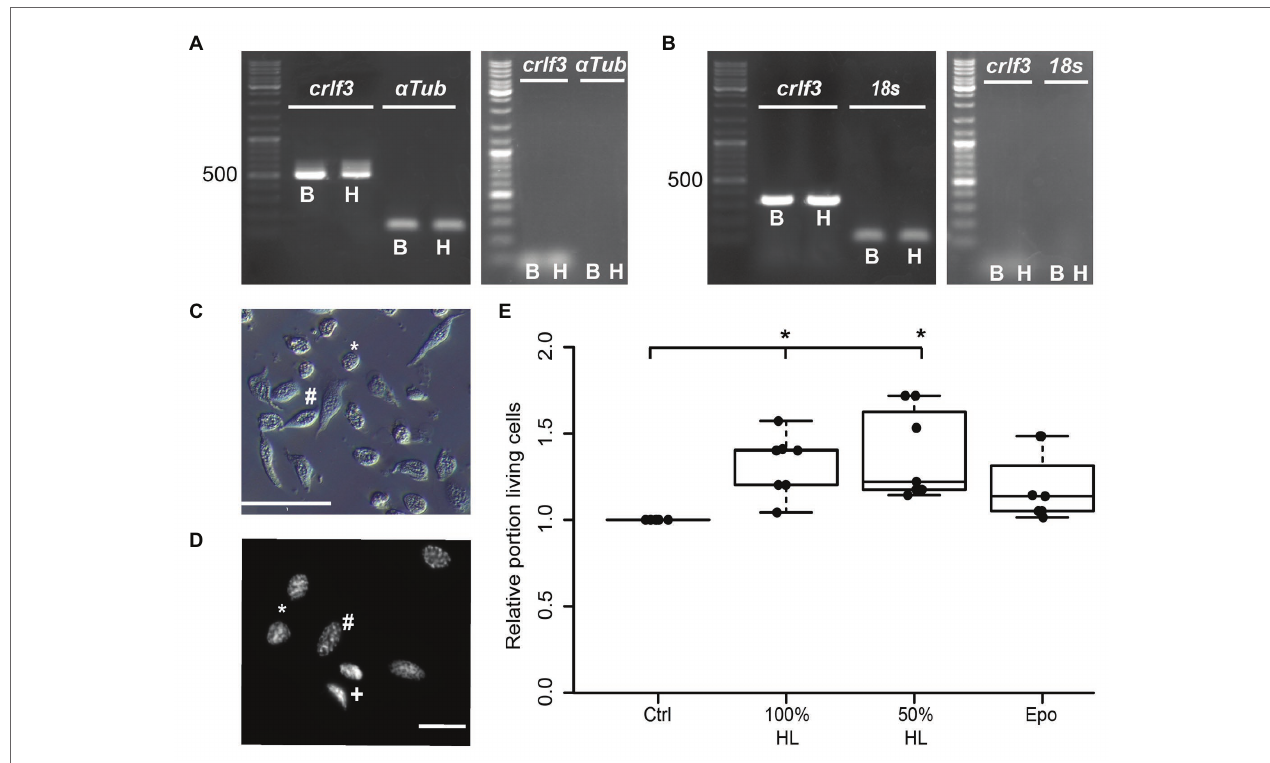
FIGURE 1 | Characterization of hemocyte cultures. (A) Reverse transcription polymerase chain reaction (RT-PCR) analysis demonstrates Tc-crlf3 expression in T. castaneum brain tissue ( B ) and hemocytes ( H ). The PCR product has the expected size of 527 bp for crlf3 amplification. α - Tubulin ( α Tub ) was used as control with a predicted amplicon of 128 bp. ( − )RT controls were negative (see right gel panel). (B) RT-PCR reveals Lm-crlf3 transcript in L. migratoria brain ( B ) and hemocytes ( H ). Both samples show clear bands for Lm - crlf3 at the expected size of 323 bp. 18s rRNA was amplified as control and generates bands at 135 bp as expected. No gDNA was detected in ( − )RT controls (see right panel). (C) Locust hemocyte cultures after 7 days in vitro contain cells of diverse morphologies. Main hemocyte populations were identified as granulocytes (*) and plasmatocytes (#). Scale bar 50 μ m. (D) Dapi-labeled nuclei of locust hemocytes. Intact cells display patchy staining reflecting normal chromatin structure (*, #). Dead/dying cells show uniformal nuclear staining (+) indicative of DNA degradation and nuclear condensation. Nuclear morphology allows for characterization of the cell type ( # phasmatocyte, *granulocyte). Scale bar 10 μ m. (E) Hemolymph promotes survival of locust hemocytes after 7 days in vitro . Both 100% hemolymph and 50% hemolymph diluted in Grace culture medium significantly increase hemocyte survival in comparison to cultures with basal Grace medium. About 33.3 ng/ml erythropoietin (Epo) had no significant effect on hemocyte survival. Statistics were calculated with pairwise permutation test followed by Benjamini Hochberg correction. n = 7; Cells evaluated: 154,983. * p <